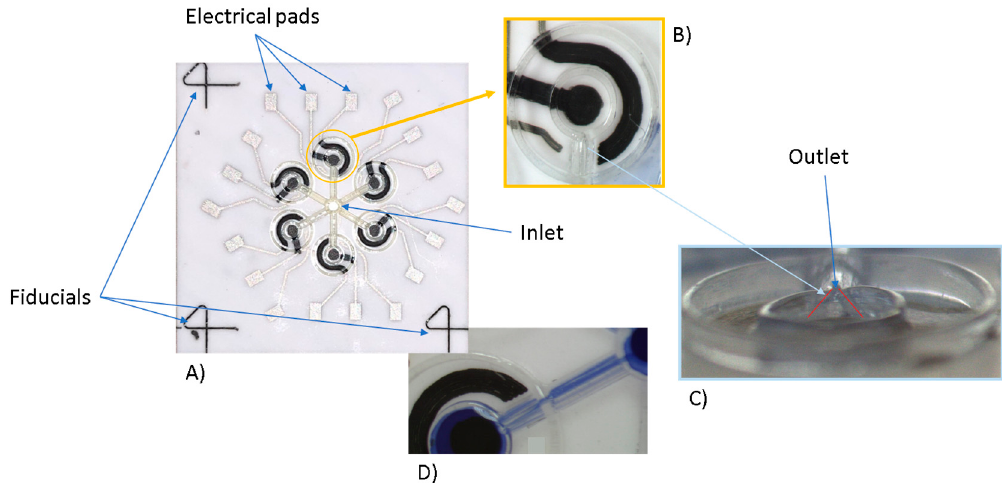
Figure 5. Final platform produced by means of AJP ( A ), with specific details of the two concentric limiting circles ( B ) and a frontal view of the triangular channel ( C ); a channel filled with pen ink ( D ).